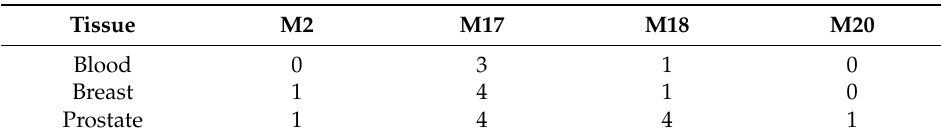
Table 5. The number of KEGG pathways that overlapped between the first-order genes of the module and the TSA targets in three TSPPI networks.